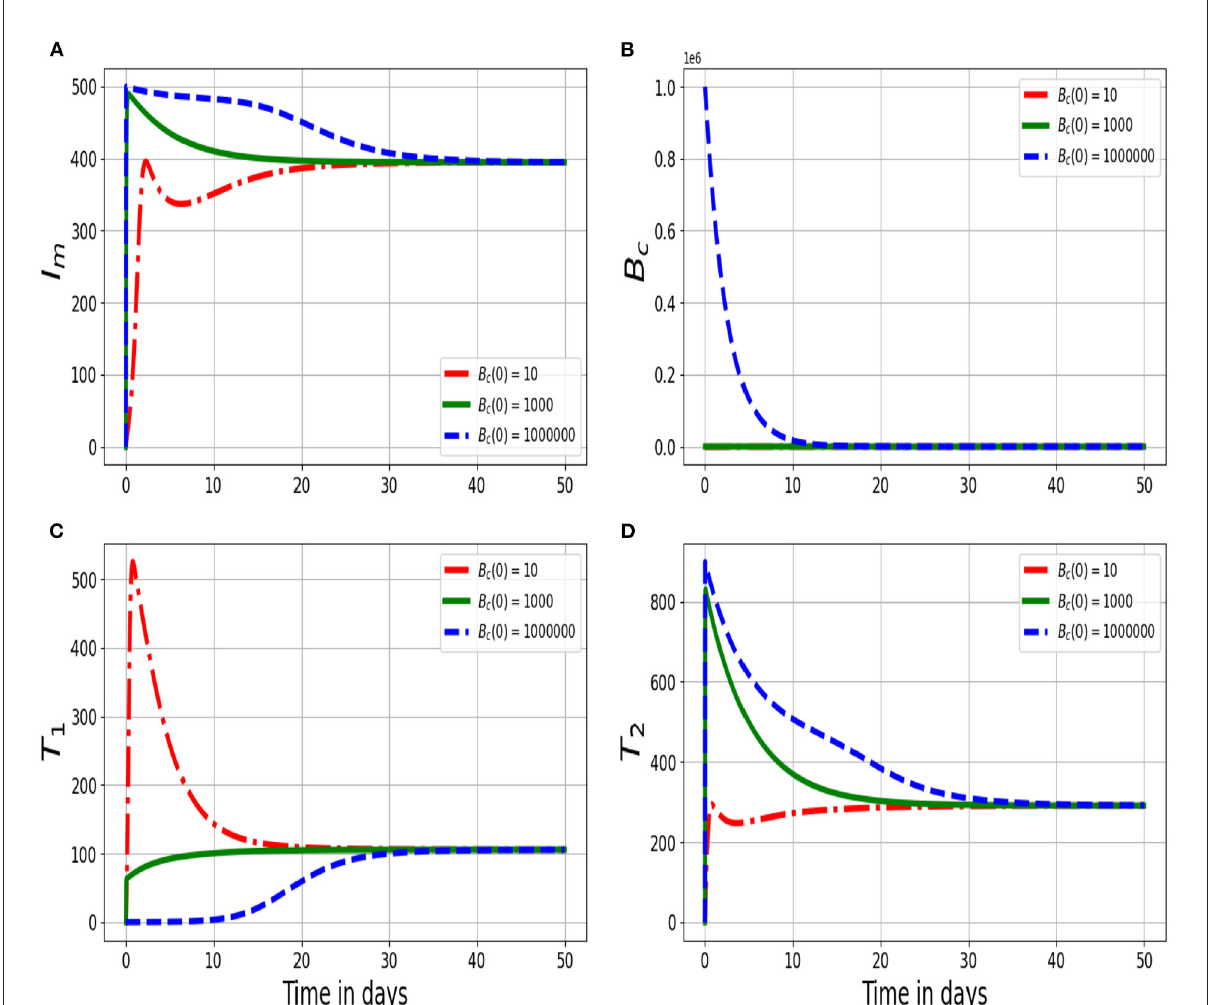
FIGURE2 Graphs of numerical solutions of the multiscale model system (2.4) showing changes of (A) infected macrophage population ( I m ), (B) within-host MAP bacteria population ( B c ), (C) MAP-Specific Th1 response cells ( T 1 ), and (D) MAP-Specific Th2 response cells ( T 2 ) for different values of initial value condition of the within-host MAP bacterial load B c (0): B c (0) = 10, B c (0) = 1,000, and B c (0) =